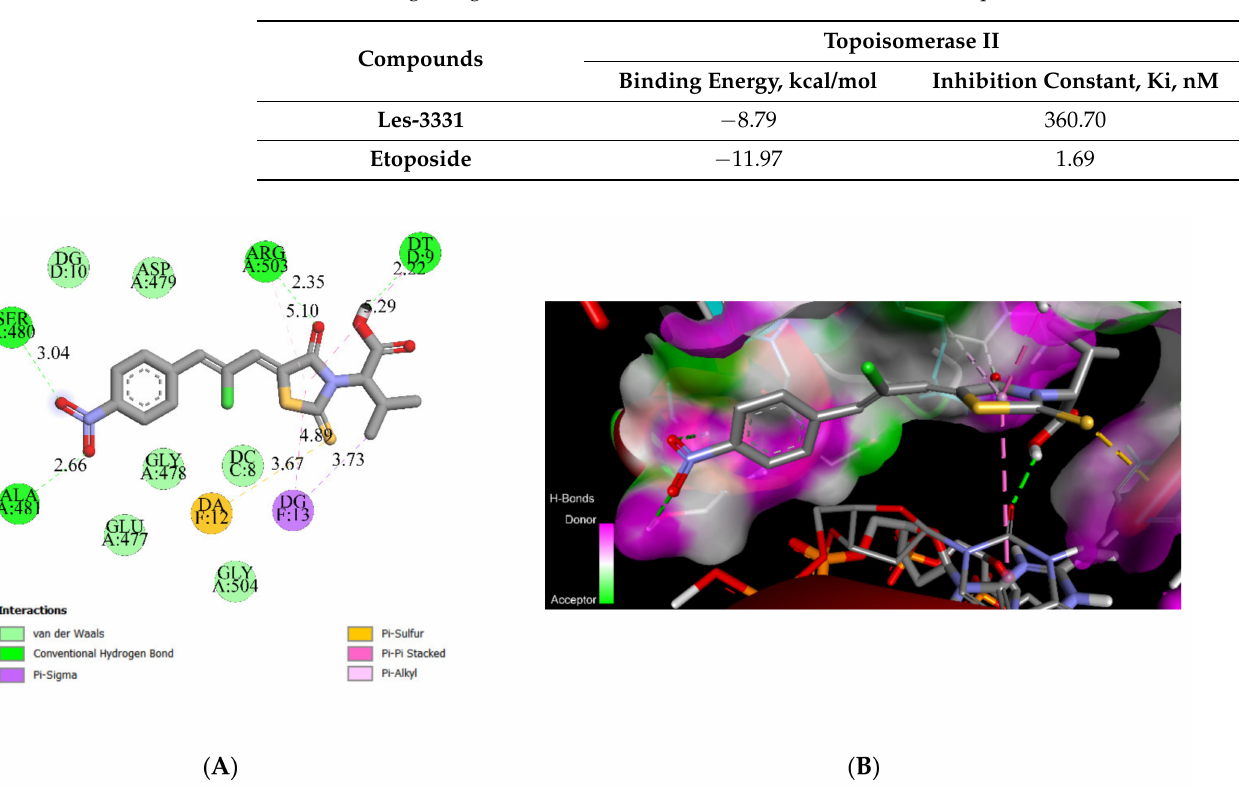
Table 1. Binding energies and inhibition constants of the Les-3331 and Topoisomerase II.